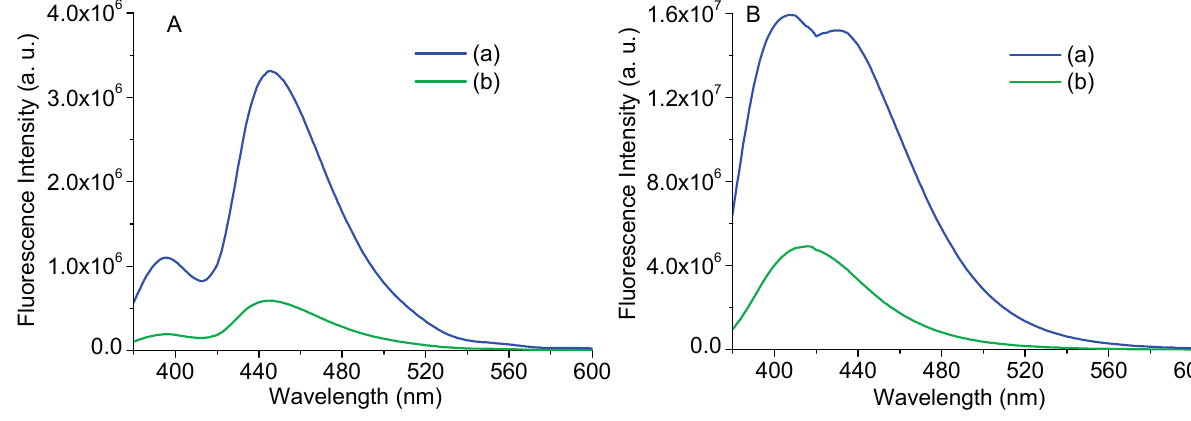
Figure 12. Bulk Fluorescence ( A ) and Intrinsic Fluorescence; ( B ) for two phantoms with different Carbostyril 124 concentrations: (a) 1.5 µg/mL; and (b) 0.15